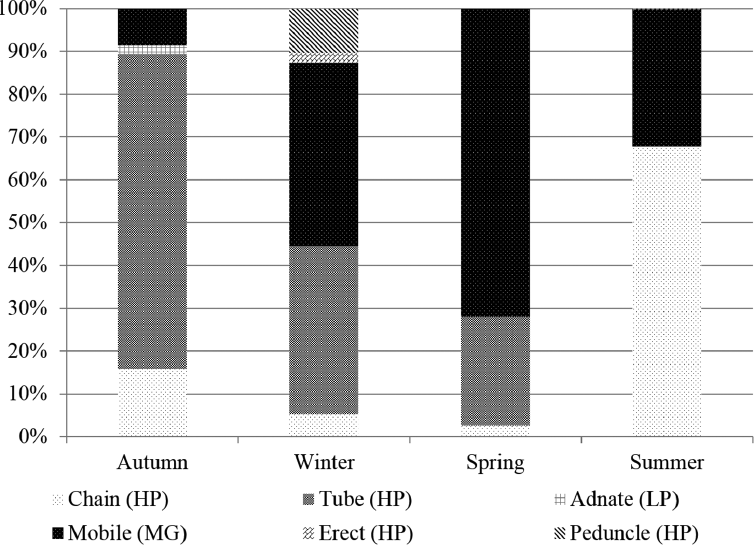
Figure 4. Relative distribution of the growth forms and type of guild (HP = high profile, LP = low profile and MG = mobile guild) in A . danaeifolium in the Pseudônimo Stream in the period of May 2011 to January 2012.